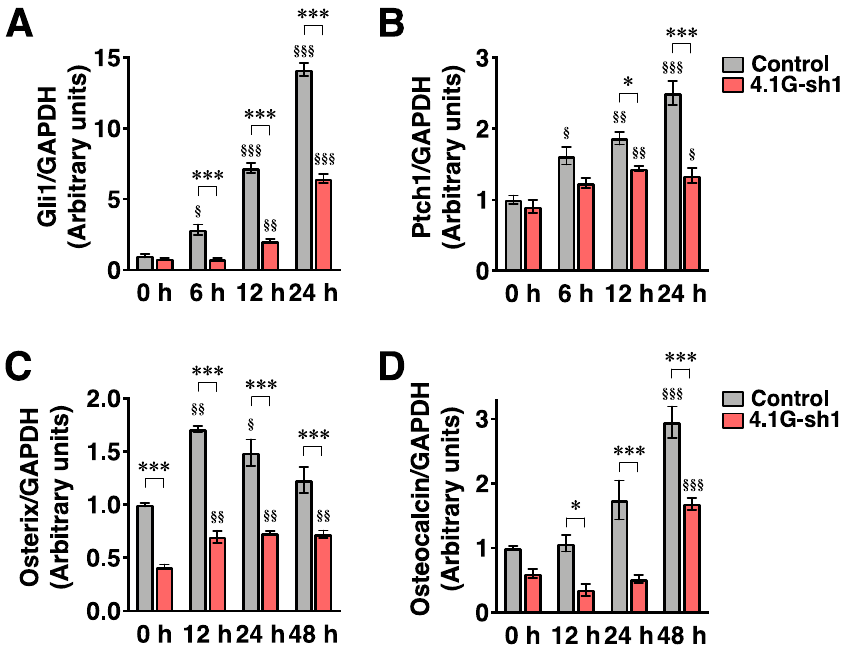
Figure 5. Protein 4.1G increases primary cilia-mediated osteogenic signals. MC3T3-E1 cells transfected with the control or 4.1G-sh1 were treated with AA/ β GP for 2 days. The cells were further stimulated with 2 µM of purmorphamine for indicated time periods. Relative mRNA expression levels of Gli1 ( A ), patched 1 (Ptch1) ( B ), osterix ( C ), or osteocalcin ( D ) were normalized to GAPDH level. Data are presented as the mean ± S.E.M. from three independent experiments. § p < 0.05, §§ p < 0.01, §§§ p < 0.001, one-way ANOVA followed by Tukey’s test (vs 0 h of the group). * p < 0.05, *** p < 0.001, two-way ANOVA followed by Bonferroni’s test.